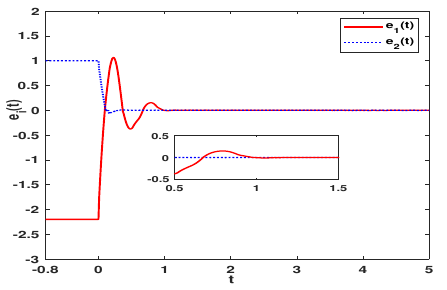
Figure 11. The synchronization errors e i ( t ) under the method in